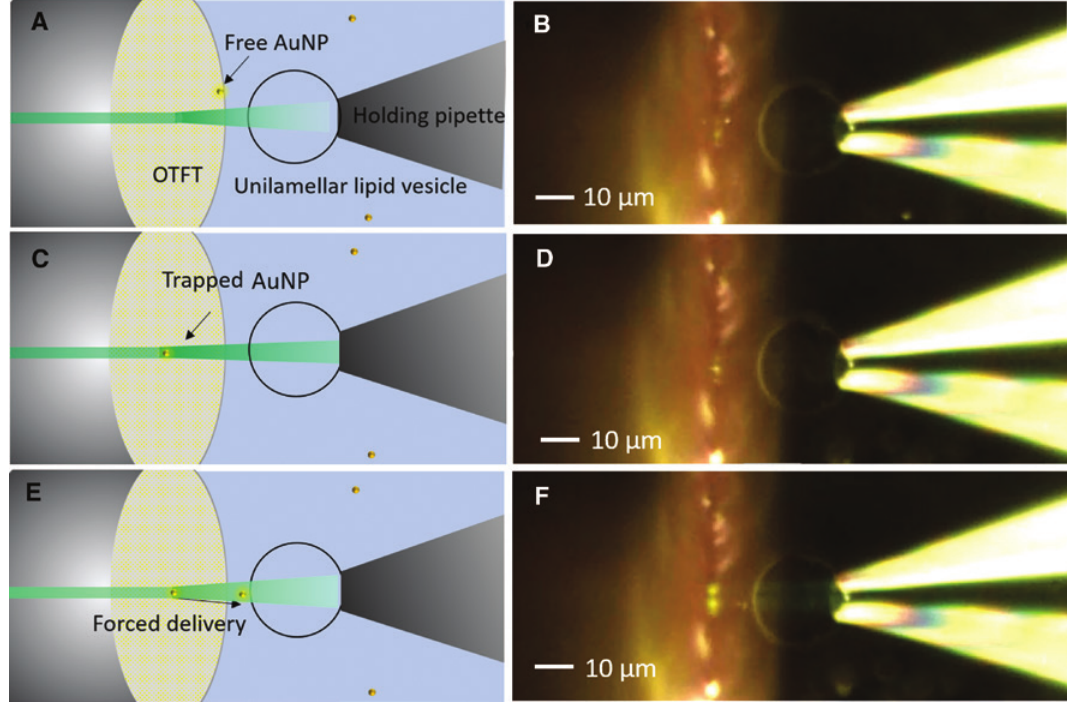
Figure 5: Remote delivery of nanoparticles. (A) Schematic showing the setup for remote delivery of nanoparticles to lipid vesicles using OTFT. (B) Microscope image showing the OTFT (parallel mode) along with the immobilized lipid vesicle with a freely diffusing 200 nm Au nanoparticle in the solution (C) Schematic showing the capture of Au nanoparticle using OTFT at low output power. (D) Microscope image showing the trapping of 200 nm Au nanoparticle using OTFT. (E) Schematic showing the forced delivery of nanoparticle using spiked output power from OTFT. (F) Microscope image showing the remote delivery of 200 nm Au nanoparticle to the lipid vesicle immobilized on the holding